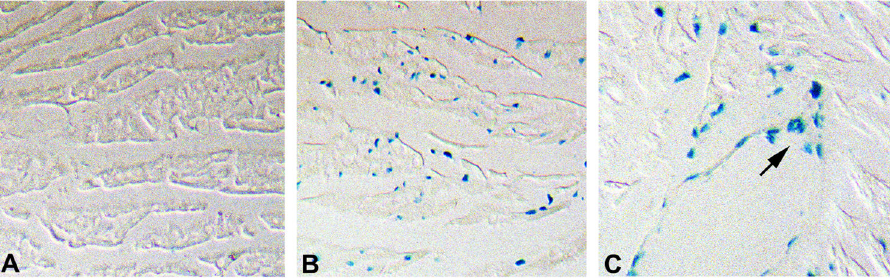
Figure 5. TUNEL staining confirms the morphologic evidence of cardiomyocyte apoptosis in NTT-MMP-2 transgenic hearts. TUNEL stain of twelve month old WT (panel A) and NTT-MMP-2 transgenic hearts (panels B, C) demonstrates diffuse cardiomyocyte apoptosis, (panel B), as well as endothelial cell apoptosis within a coronary artery (panel C, arrow). Final magnifications: A, B X 200; C X 300.